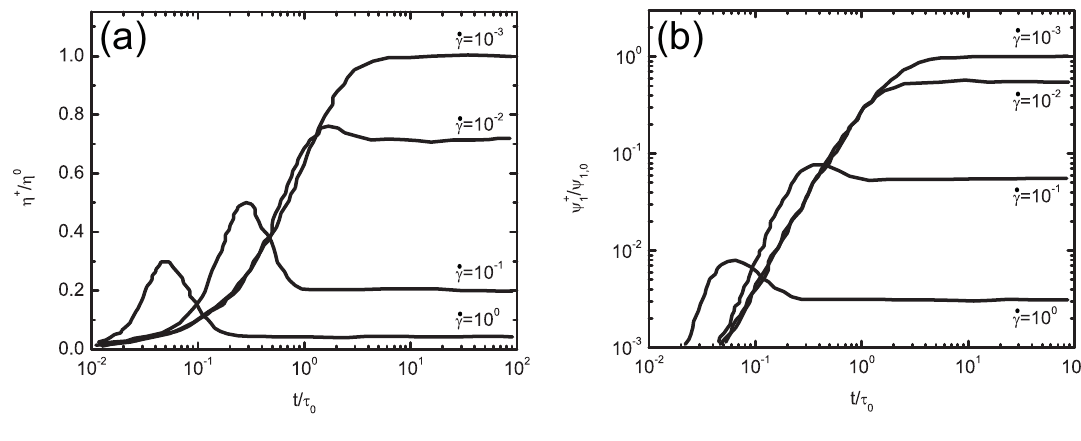
Figure 20. ( a ) Normalized shear viscosity, η + /η 0 , and ( b ) normalized first normal stress / Ψ coefficient, Ψ + , for FENE chains with length N = 20 1 , 0 1